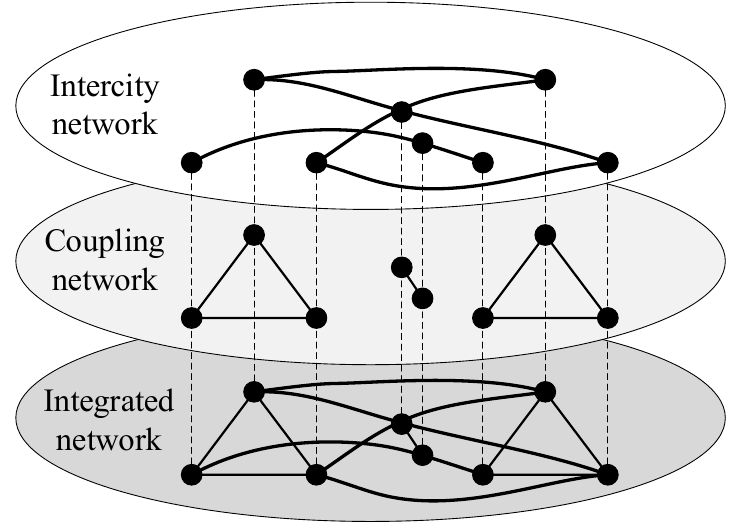
Figure 2. Schematic diagram of the integrated network.